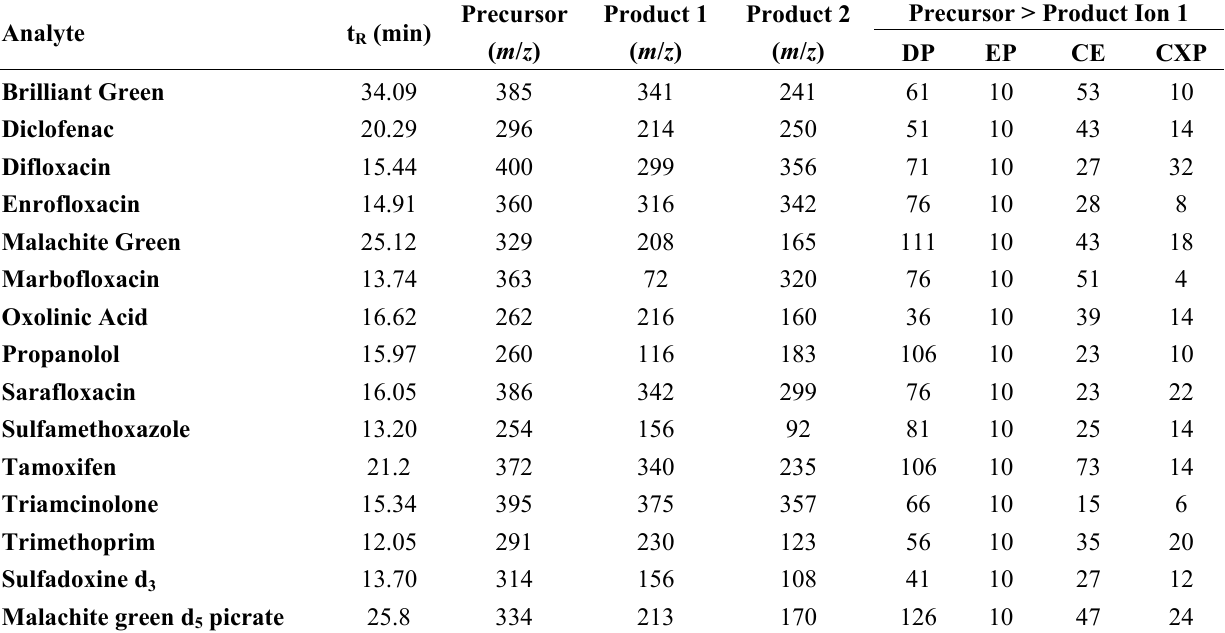
Table 3. Retention time (t ), precursor and product ions and MS parameters employed to R identify the selected